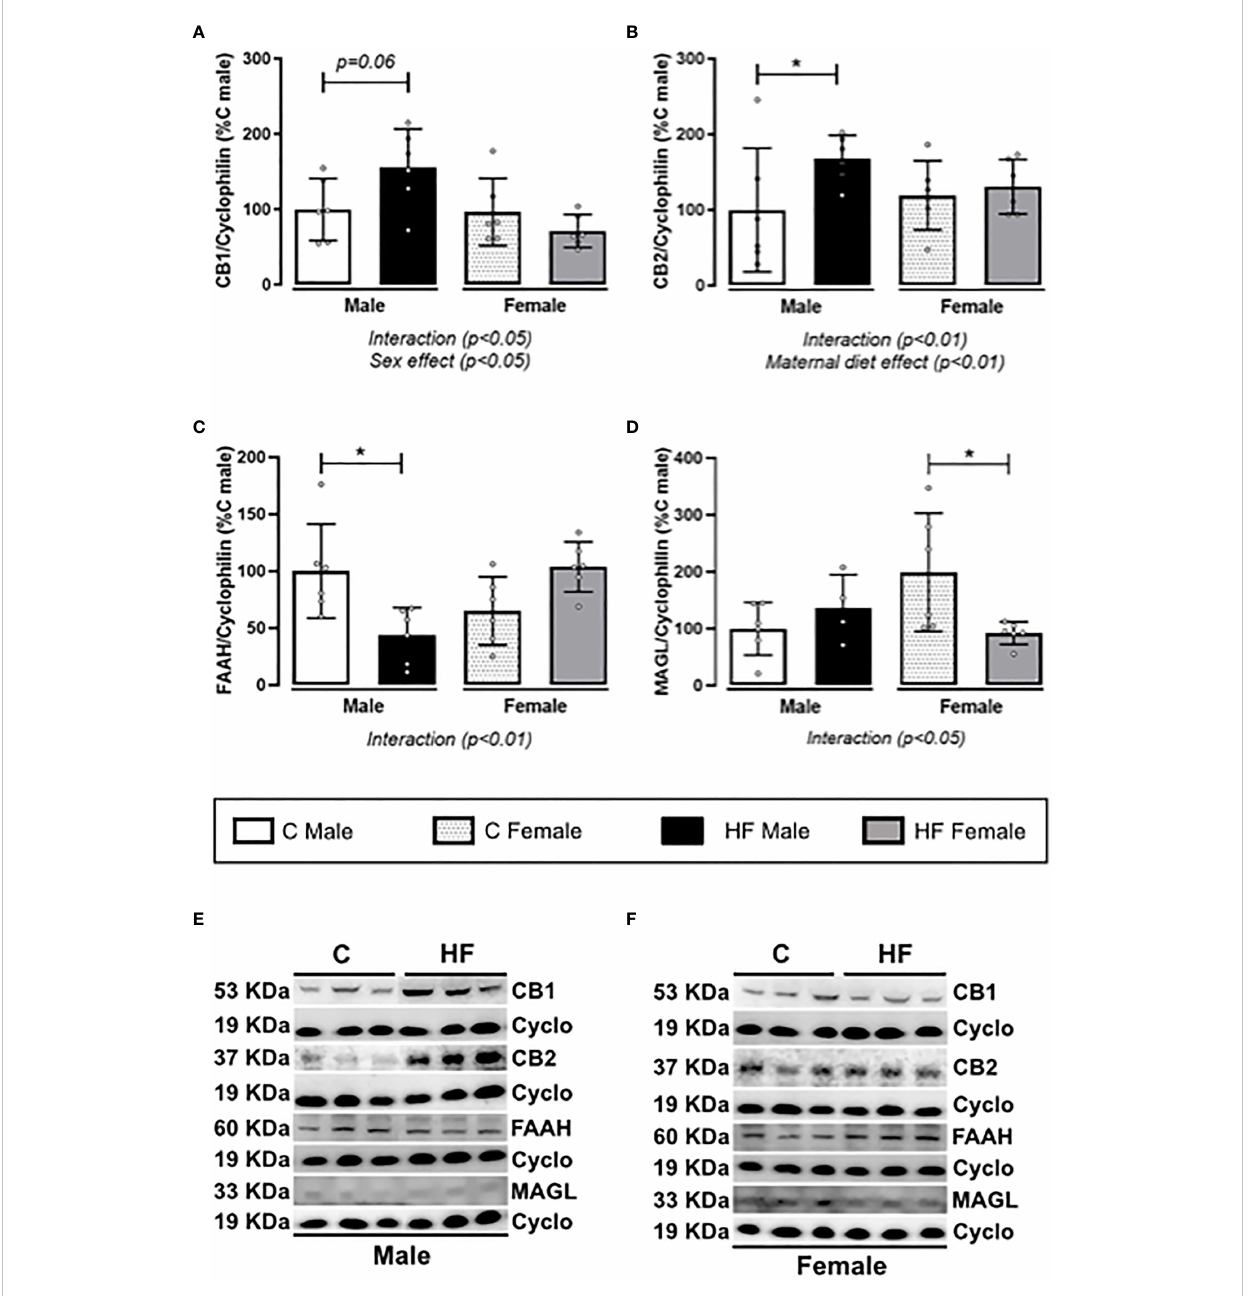
FIGURE 6 Effect of maternal high-fat (HF) diet on the endocannabinoid signaling in the Nucleus Accumbens (NAc) of weanling offspring. (A) Type-1 cannabinoid receptor (CB1); (B) type-2 cannabinoid receptor (CB2); (C) fatty acid amide hydrolase (FAAH); and (D) monoacylglycerol lipase (MAGL) protein content in the NAc of control (C) and HF male and female offspring at weaning. (E, F) representative blots are shown. Data are expressed as percentage of control male group (set at 100%) ± standard deviation. Statistically signi fi cant differences were determined by two-way ANOVA followed by Bonferroni ’ s test. * p < 0.05